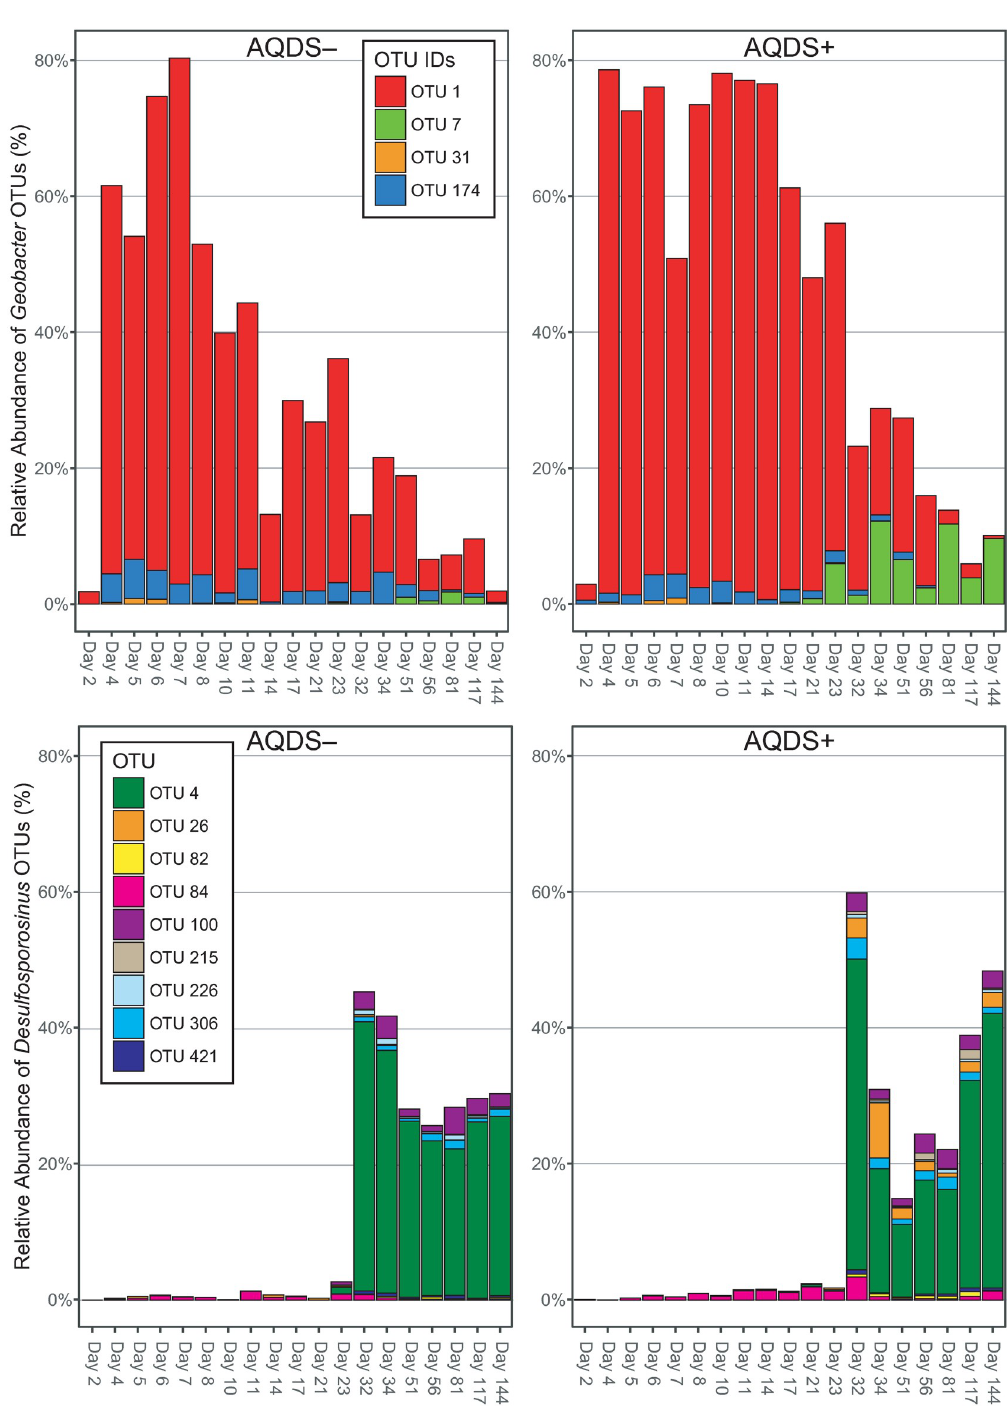
Fig 7. Relative abundance of Geobacter and Desulfosporosinus . Relative abundance of operational taxonomic units (OTUs) classified as Geobacter or Desulfosporosinus in AQDS+ and AQDS–bioreactors.